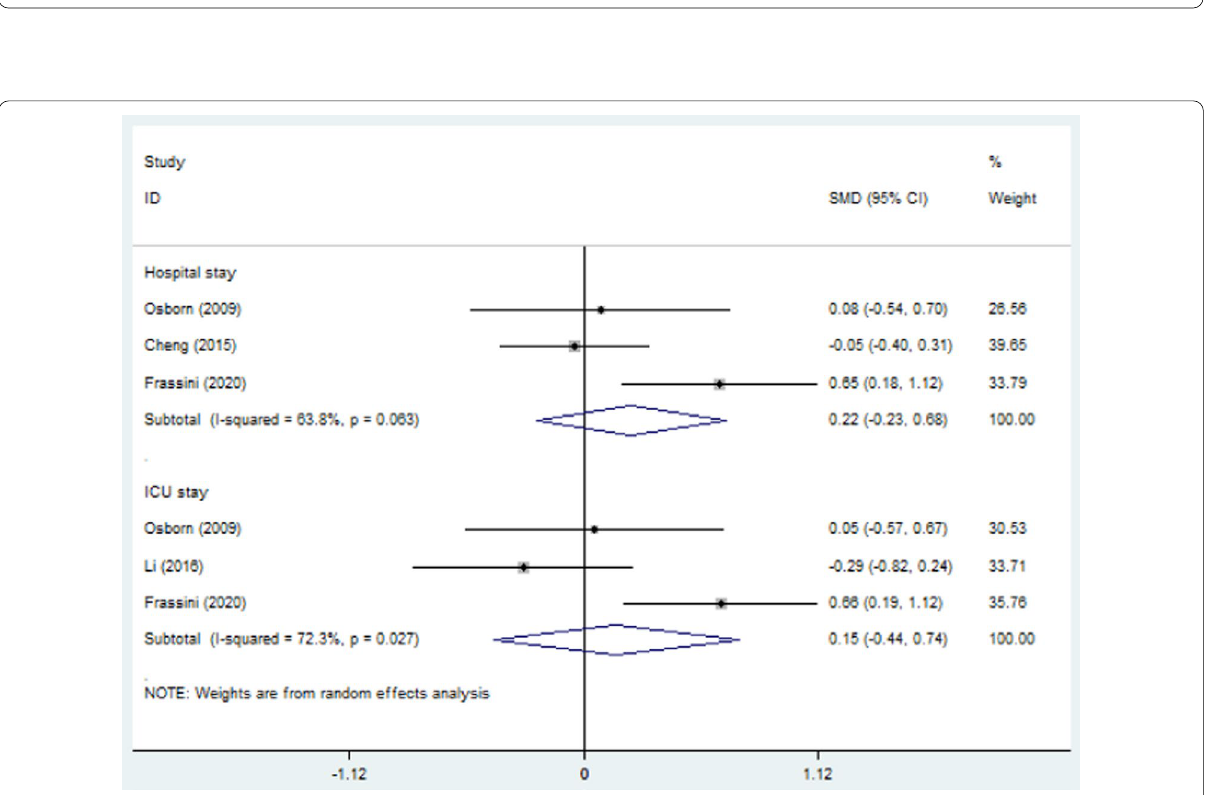
Fig. 7 Forest plot involving a comparison of length of hospitalization. SMD standard mean difference, CI confidence